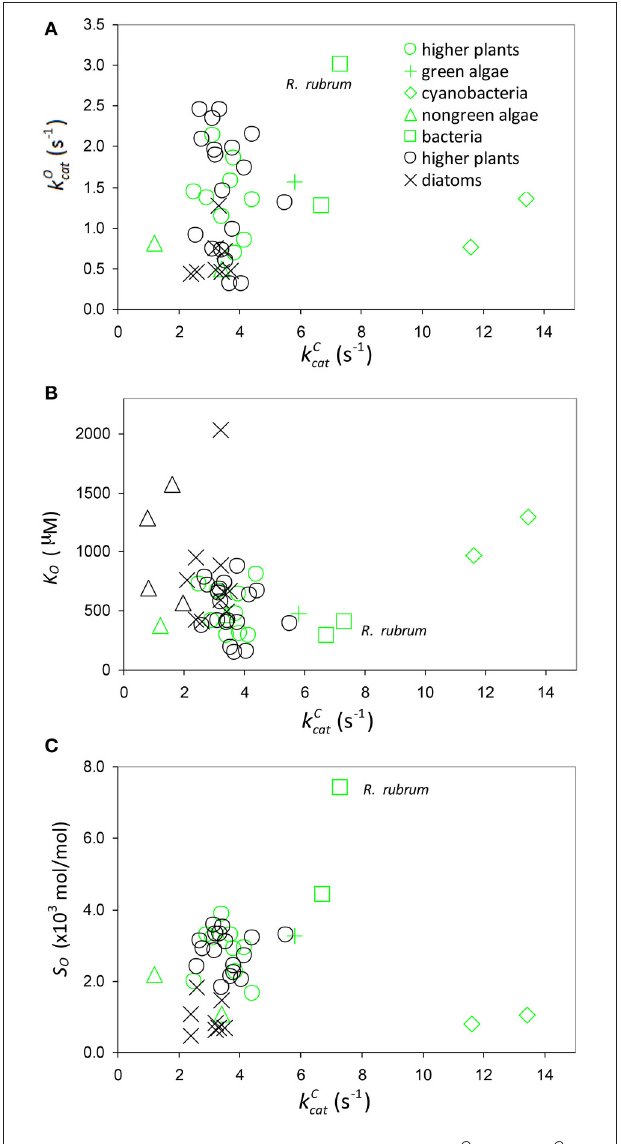
O C cat cat including all data in K O , against k